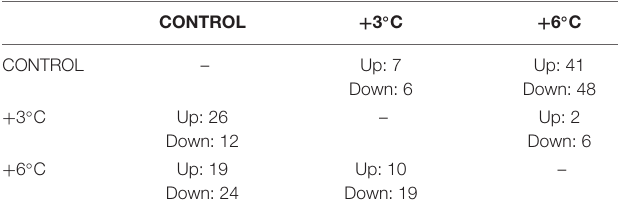
TABLE 2 | Number of significantly differentially expressed genes (DEGs) in adult pinfish ( p -adj < 0.05).